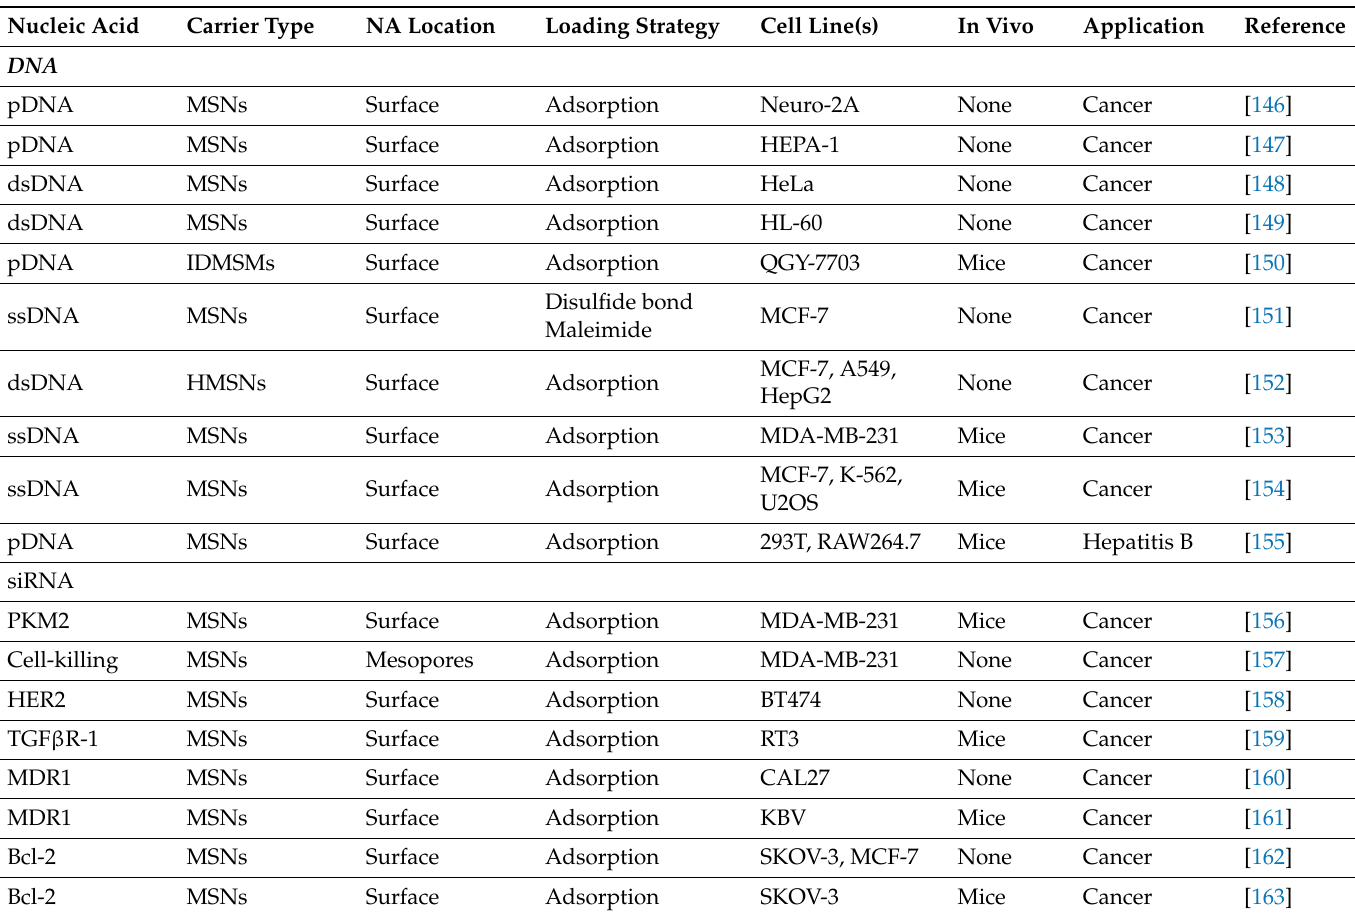
Table 3. Examples of di ff erent therapeutic nucleic acids delivered by silica-based